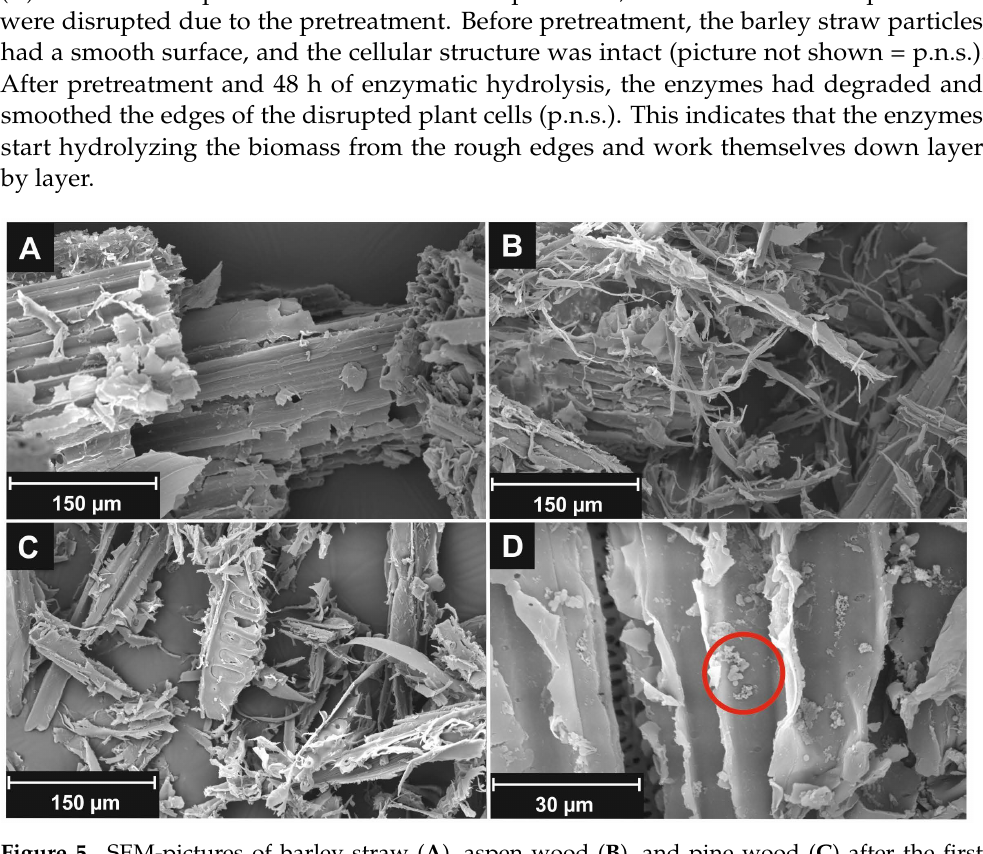
Figure 5. SEM-pictures of barley straw ( A ), aspen wood ( B ), and pine wood ( C ) after the first pretreatment at 175 ◦ C. The fourth picture ( D ) shows barley straw after the second pretreatment at 200 ◦ C. The red circle on picture D indicates the presence of repolymerized lignin or pseudo-lignin on the biomass surface after